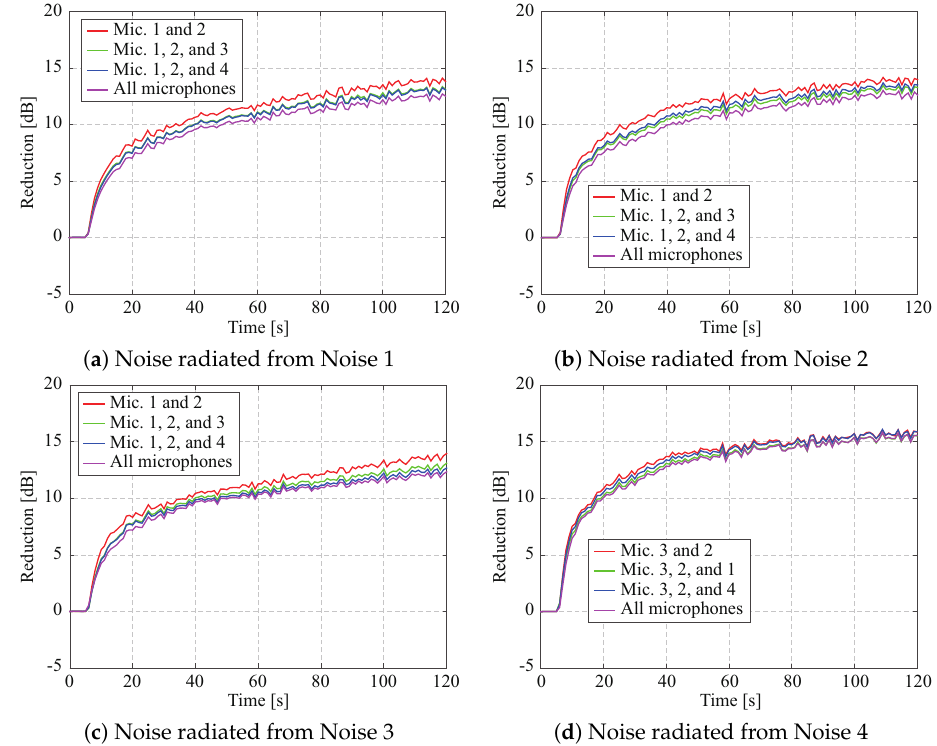
Figure 12. Noise reduction performance of three- or four-channel feedforward ANC system in